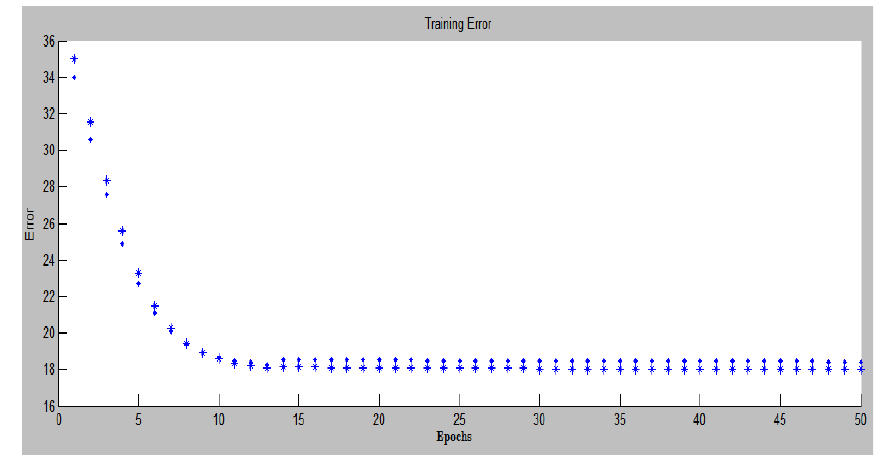
Figure 11. Error curve after system training.